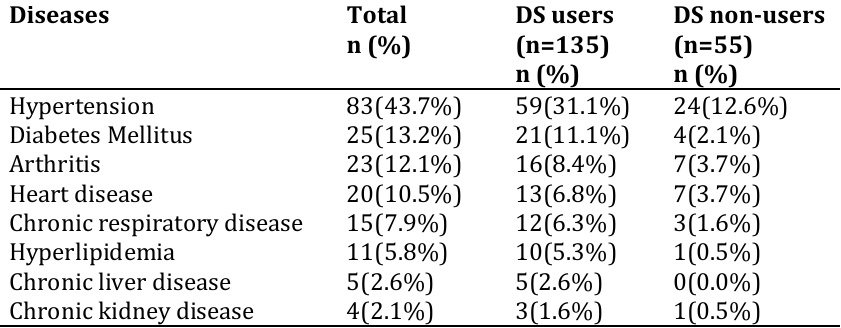
Table 2: Frequency and percentage of respondents with chronic diseases